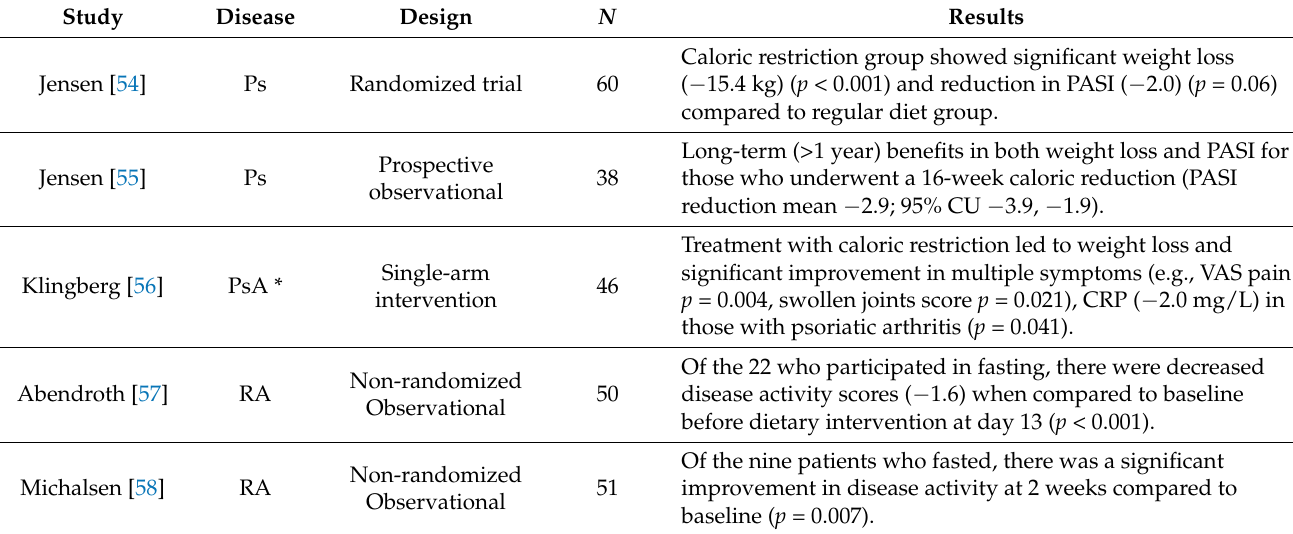
Table 3. Summary of caloric restriction/fasting studies in rheumatoid arthritis and psoriasis with potential applicability to IBD. Data have been promising for both systemic and anti-inflammatory benefits. This diet could be of benefit to specific groups of patients with IBD who are not